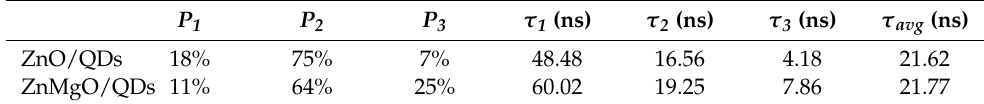
Table 1. Fitting parameters for various PL decays of ZnO/QDs and